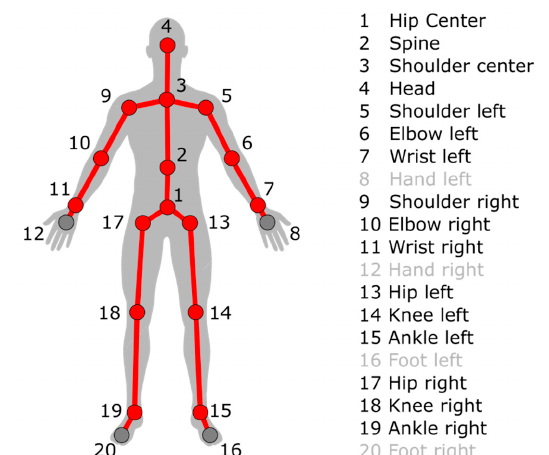
Figure 2. Skeletal data provided by the Kinect V2. On the left is the graphical representation. The node numbering is on the right. The 16 nodes considered in our algorithm are the ones in red.